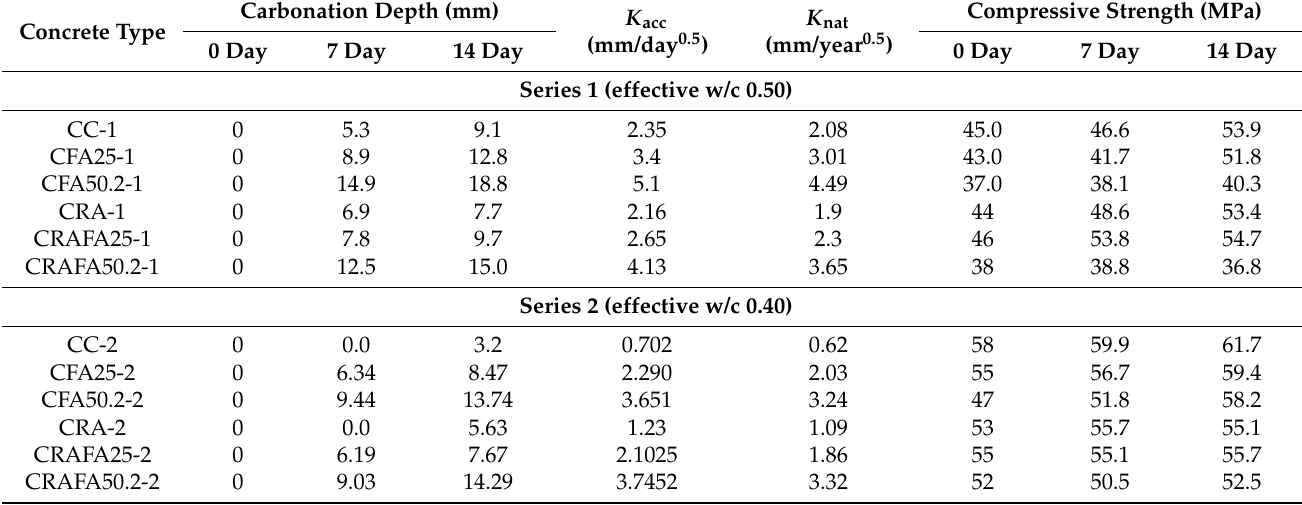
Table 4. Carbonation depth and compressive strength after the accelerated carbonation process of all concretes produced in Series 1 and Series 2.